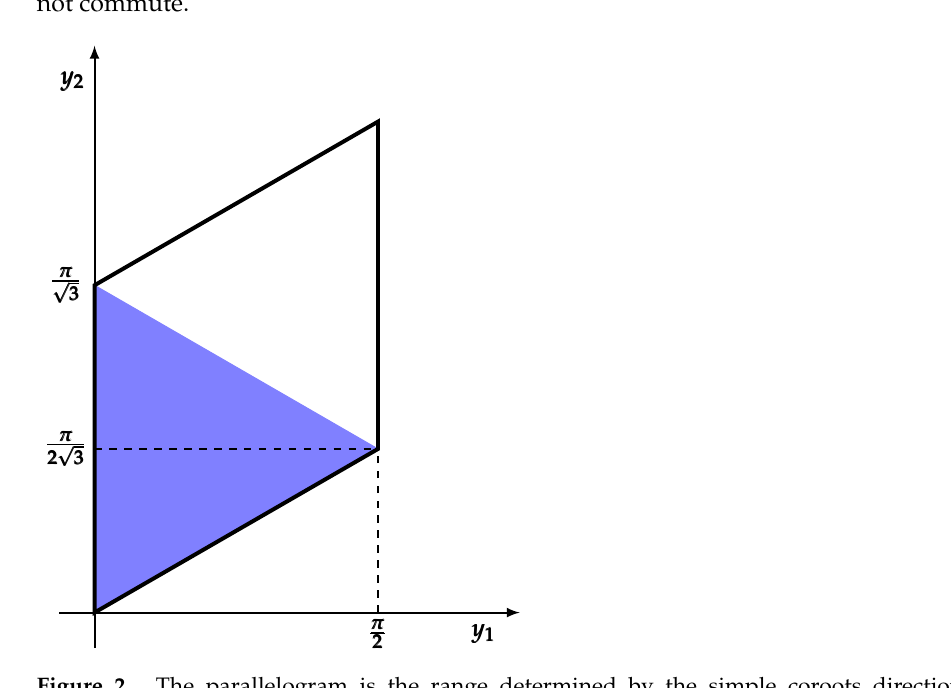
Figure 2. The parallelogram is the range determined by the simple coroots direction only. The coloured half is the fundamental